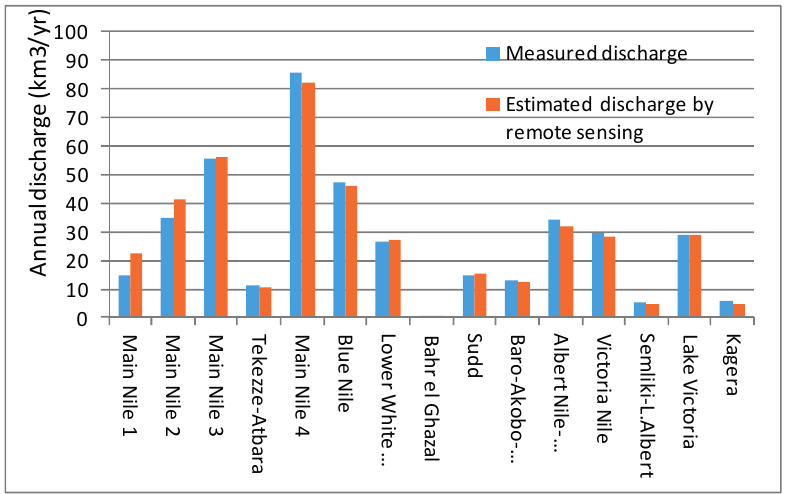
Figure 6. Relationship between estimated outflow through the main outlet of each sub-basin for the period 2005–2010 and the longer term averaged measured river